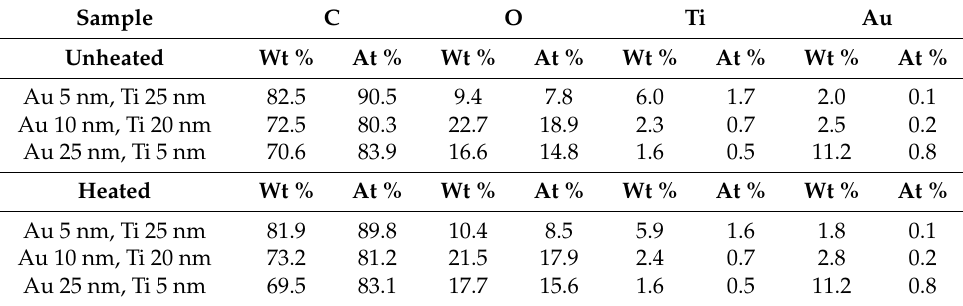
Table 3. The concentration of individual elements contained in unheated and heated samples with a lower layer of gold and a top layer of titanium obtained by EDS. Values for mass (Wt) and atomic (At) percentages.